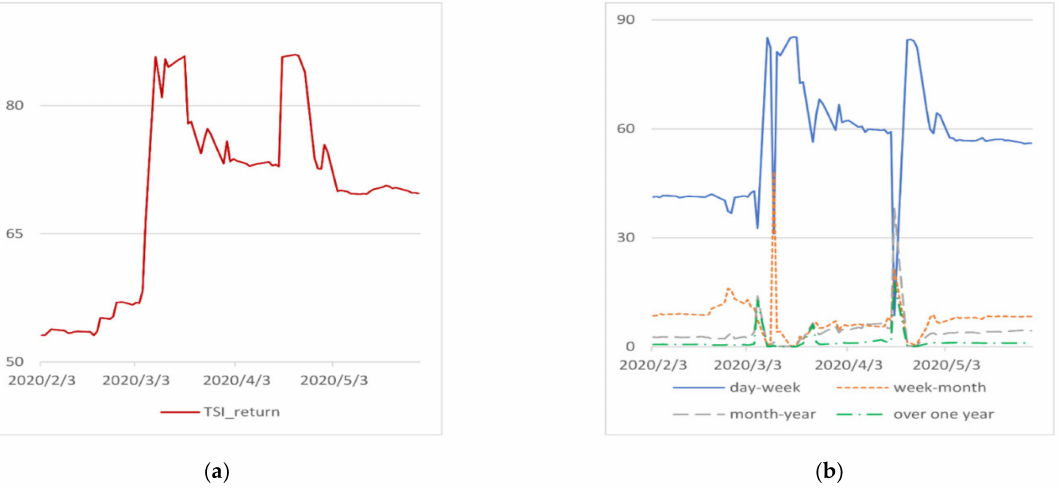
Figure 8. Total spillover of the price return system during COVID-19. ( a ) total return spillover. ( b ) frequency decomposition of return spillover.